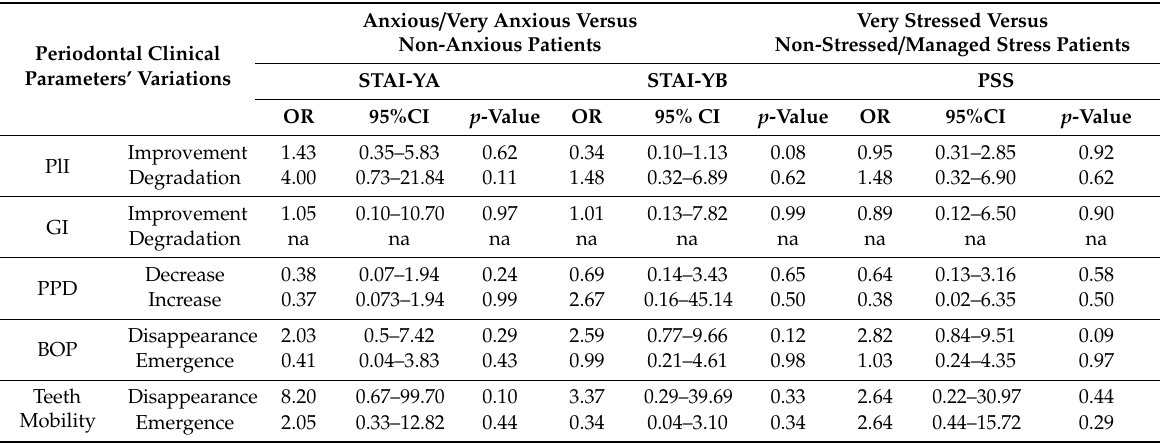
Table 4. E ff ect of stress and anxiety on the evolution before-after treatment of periodontal clinical parameters from diseased patients.